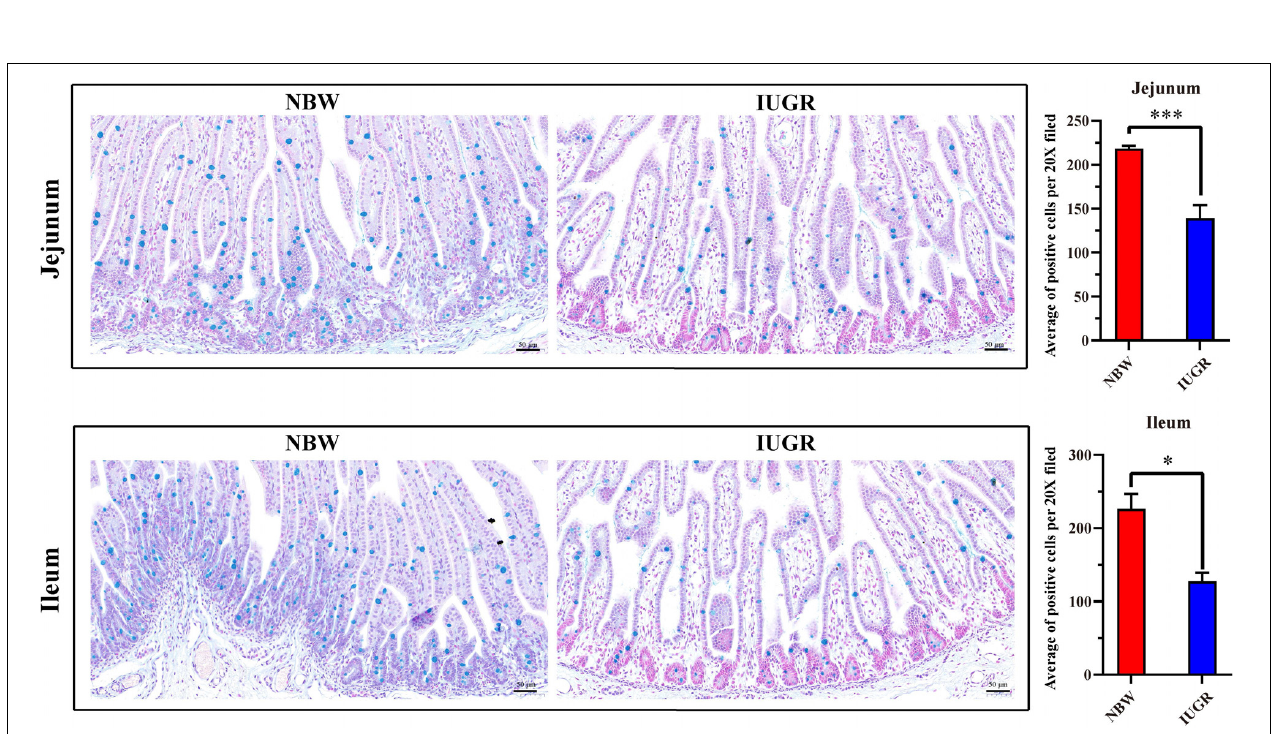
FIGURE 5 | Alcian blue staining on jejunum and ileum in NBW and IUGR piglets. Data are shown as mean ± SEM. ∗ P < 0.05, ∗∗∗ P < 0.001. n = 3 per group. NBW, normal body weight; IUGR, intrauterine growth restriction. Bar = 50 µ m.